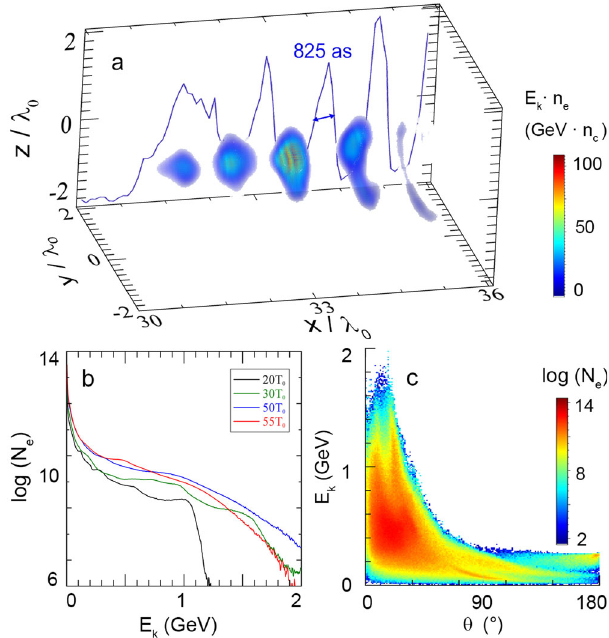
Fig. 2 Formation and acceleration of GeV electron bunches. Dense sub- femtosecond electron bunches are formed with a high cutoff energy (~2 GeV), large energy density (~10 5 MeV· n c ) and sub-femtosecond full width at half maximum (FWHM) duration (~825 as). a Energy density distribution of electrons at t = 45 T 0 . Here the on-axis electron density distribution is illuminated in the x − z plane. b Evolution of the electron energy spectrum. c Electron angle-energy distribution right before the laser-electron collision ( t = 50 T 0